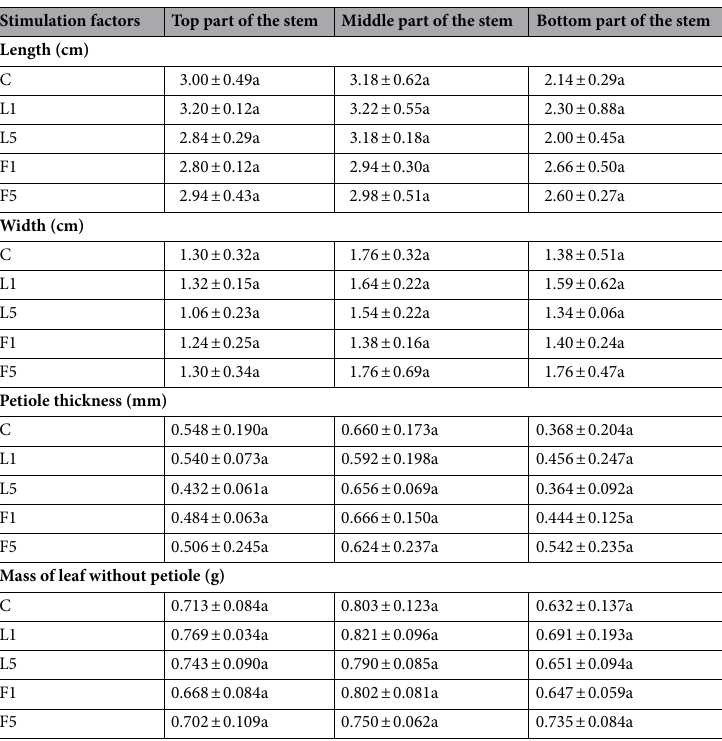
Table 1. Parameters characterizing alfalfa leaves. C control (unstimulated seeds); L1, L5 He–Ne laser light stimulation with 1 and 5 min exposure, respectively, F1, F5 alternating magnetic field stimulation with 1 and 5 min exposure, respectively. a, b—different letters in respective columns indicate statistical differences, ± standard deviation, n = 5.